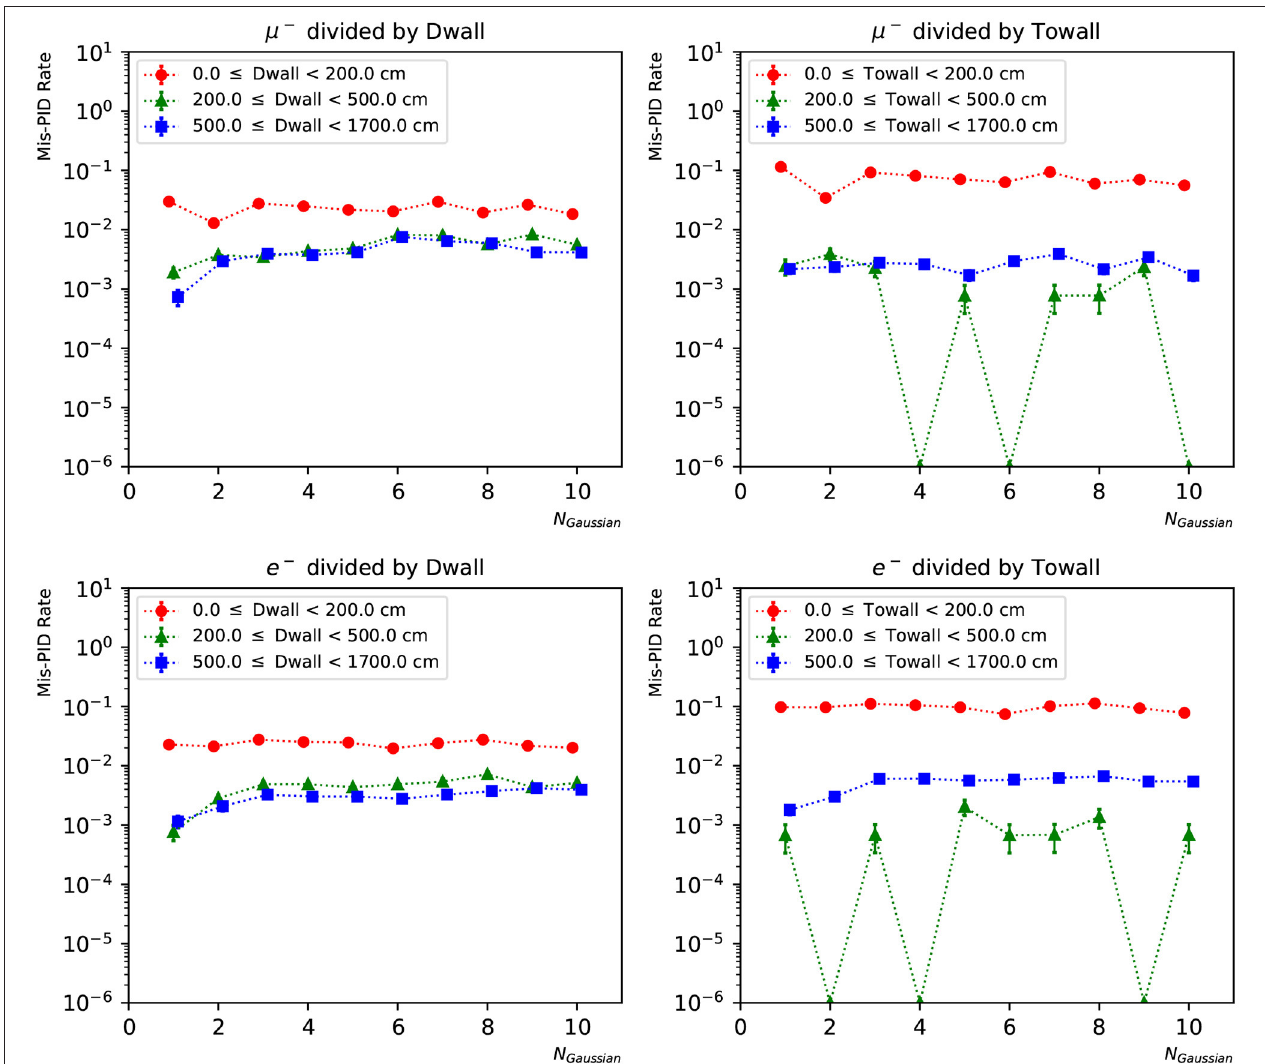
FIGURE 13 | The particle mis-identification rate of charge-time correlated networks with 1 regions are 0 200, 200 500, and 500 cm from the detector walls. The left column shows dependence of “dwall” and the right “towall”. Statistical errors are also ∼ ∼ ≥